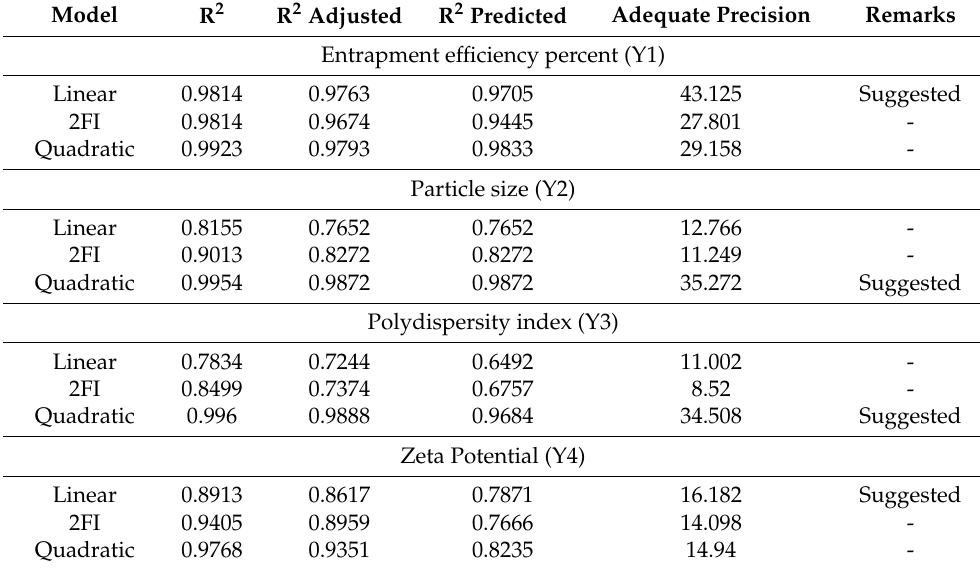
Table 4. ANOVA analysis of the investigated